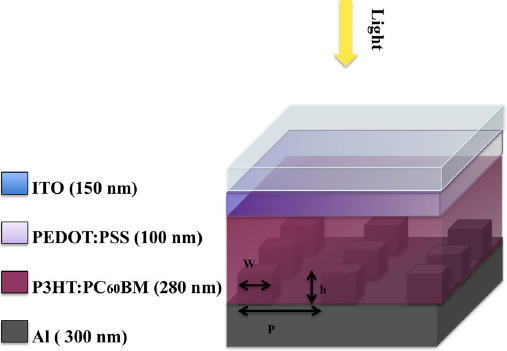
Figure 1. Organic solar cell model geometry, with a back contact grating and material thicknesses as used in the simulations (h – pillar height [nm], p – grating period [nm], w – pillar width